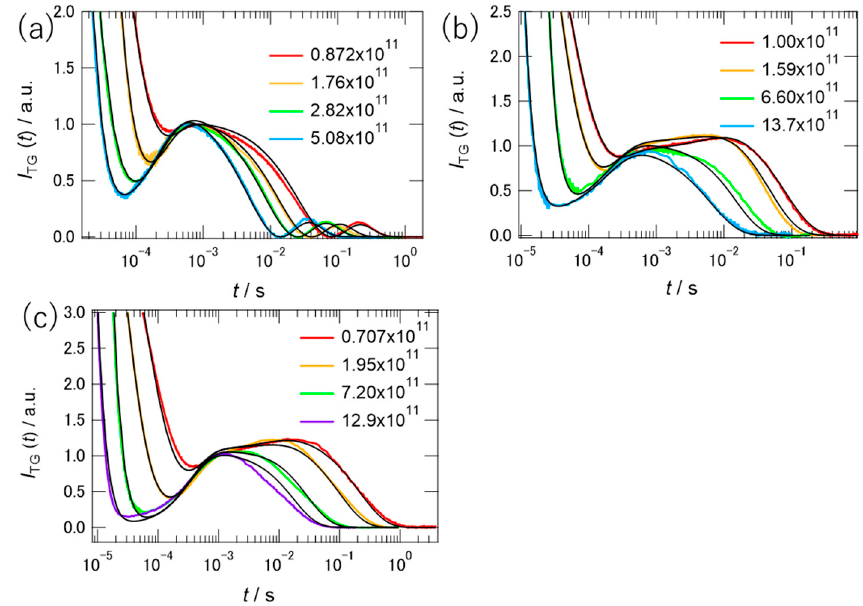
Figure 5. TG signals of PYP in ( a ) 10, ( b ) 30, and ( c ) 49 wt% of [ch][dhp]. The signal intensities were normalized relative to the peak at 10 − 3 s. The values of q 2 in ( a − c ) are listed in the graph in the unit of m − 2 . The black curves are fitting curves.